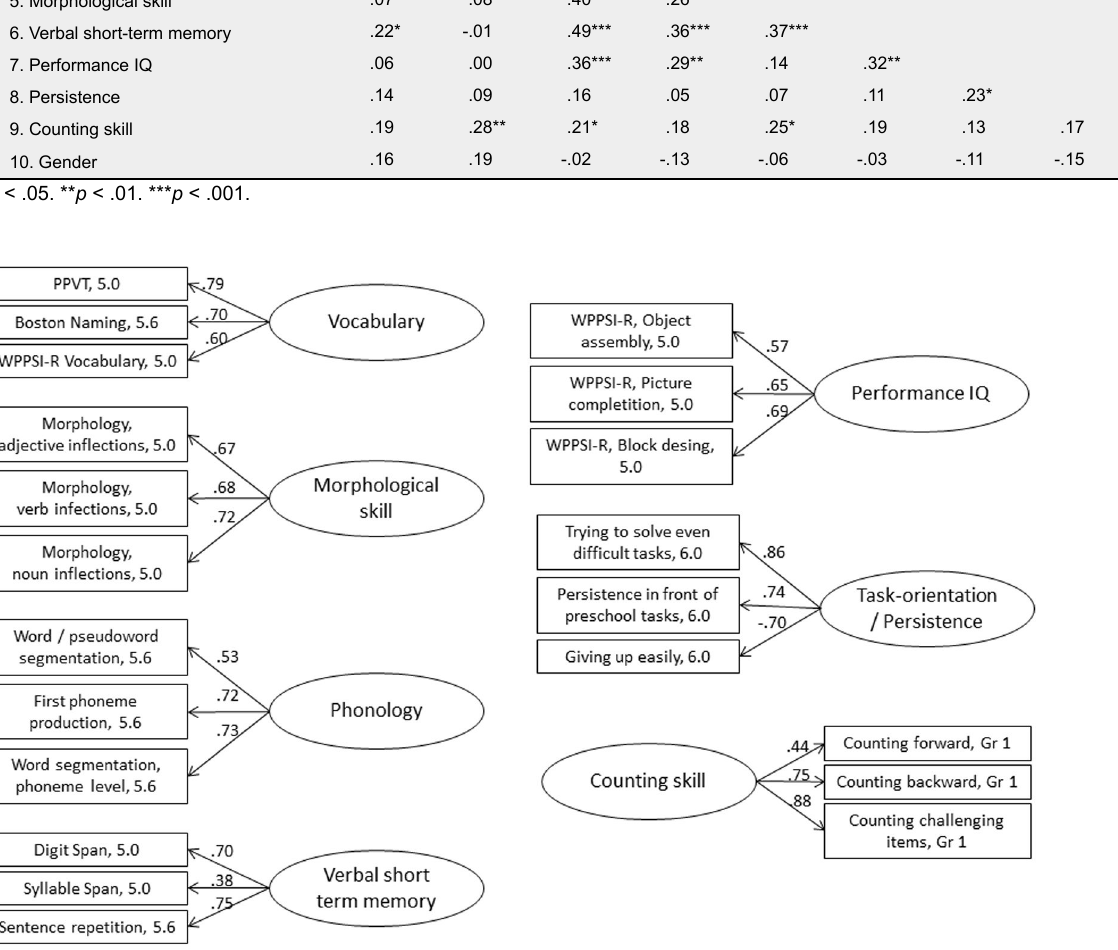
Figure 1. Factor constructs of the cognitive predictors at age of five, task-orientation and persistence, and counting